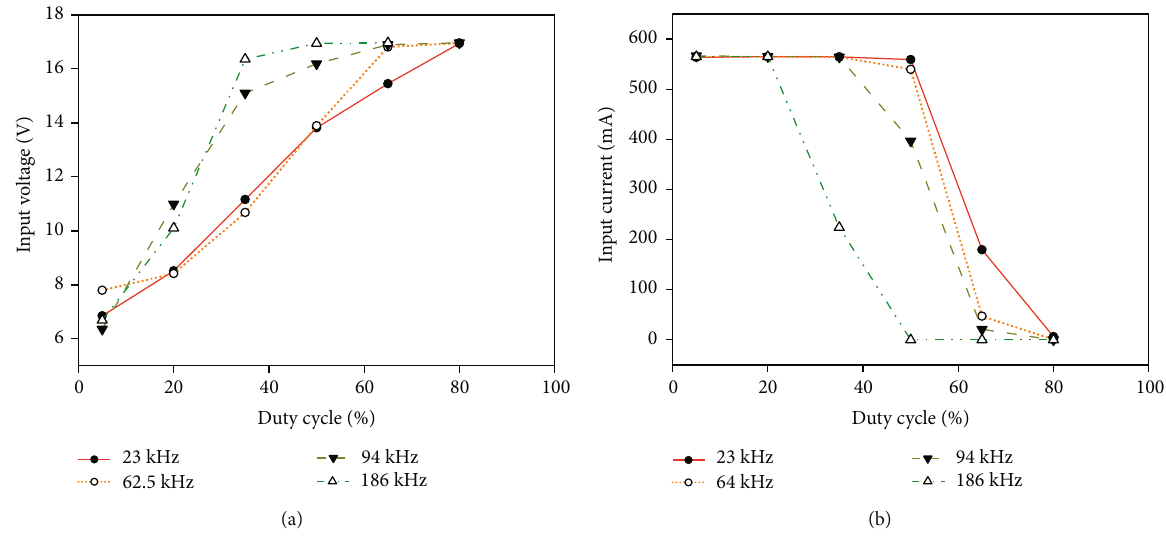
Figure 11: Solar module voltage and current behavior: (a) input voltage vs. DC; (b) input current vs. DC.